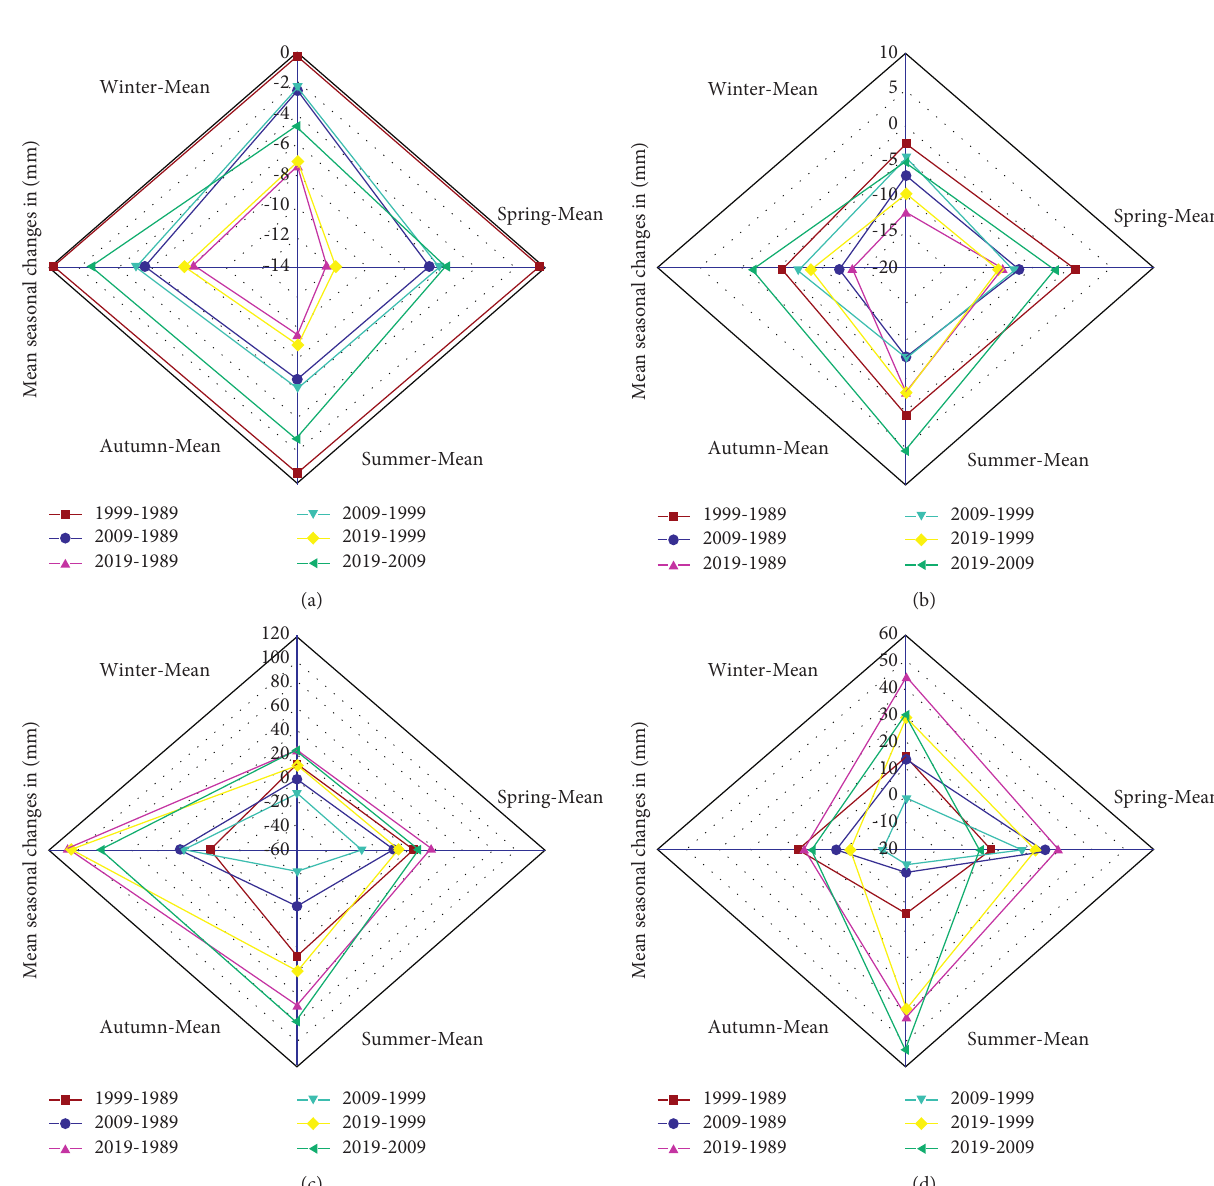
Figure 12: Long-term mean seasonal WetSpass simulated hydrologic water balance component changes of the Bilate basin for a LULC (1989, 1999, 2009, and 2019) where (a) mean seasonal interception changes in mm, (b) mean seasonal recharge changes in mm, (c) mean seasonal surface runoff changes in mm, and (d) mean seasonal EVT changes in